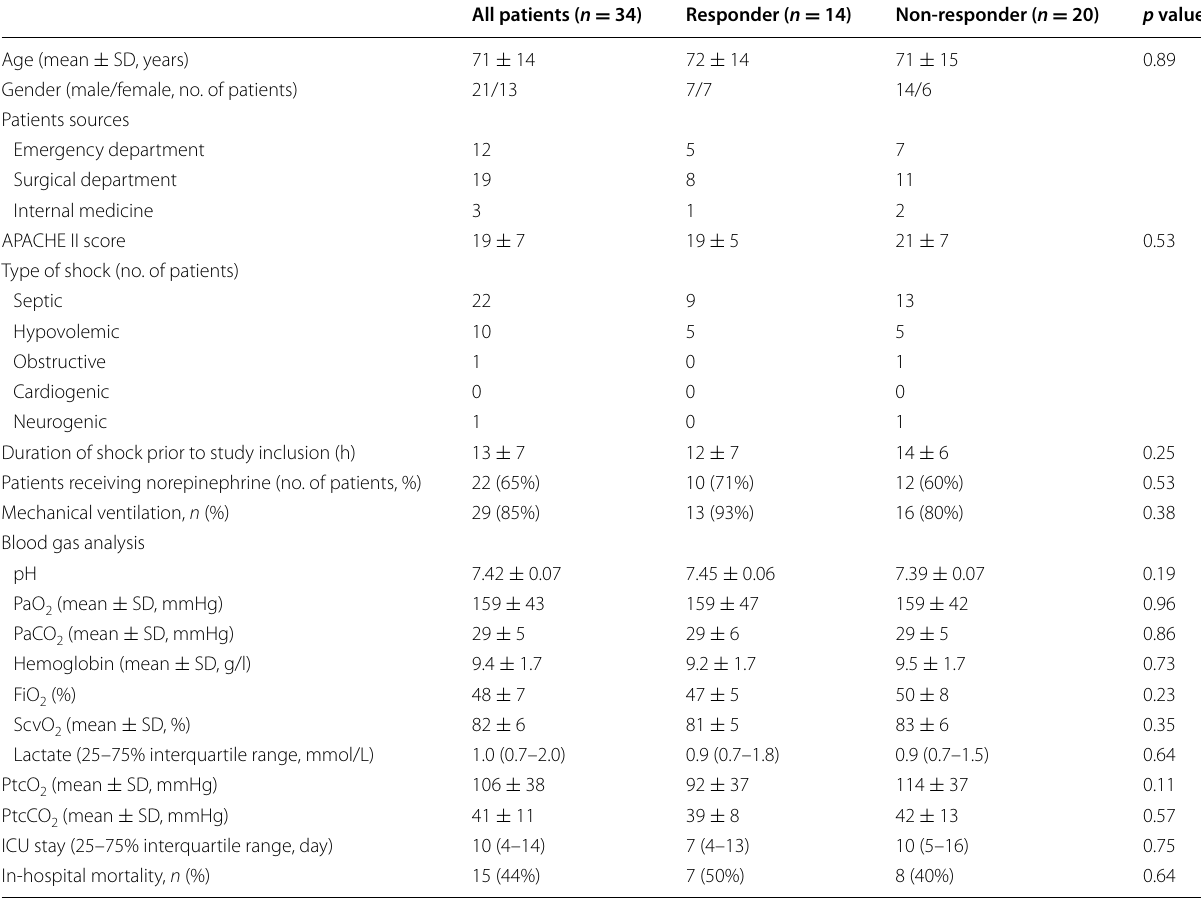
Table 1 Characteristics of patients. * p < 0.05 versus